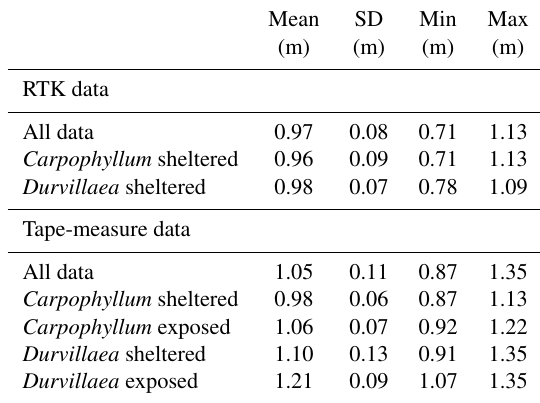
Table 4. Comparison of uplift results for data collected by RTK and tape measure at the tide gauge, including a comparison of kelp types in both sheltered and exposed locations. Results are presented by holdfast species and exposure ranking independently of the col- lection